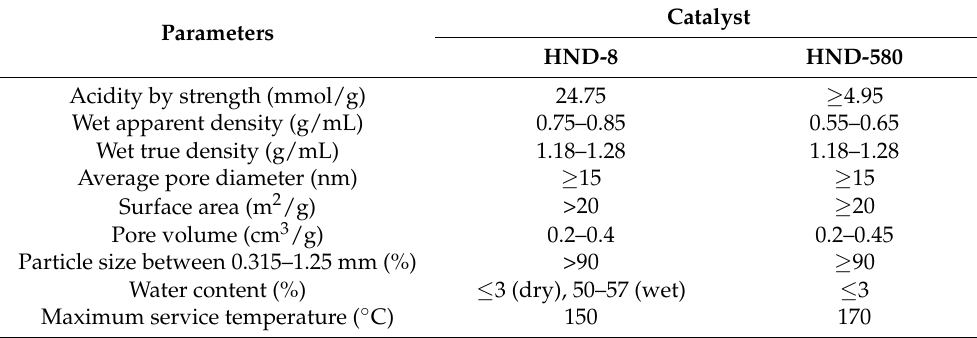
Table 5. The characteristics of super solid acid catalysts HND-8 and HND-580.